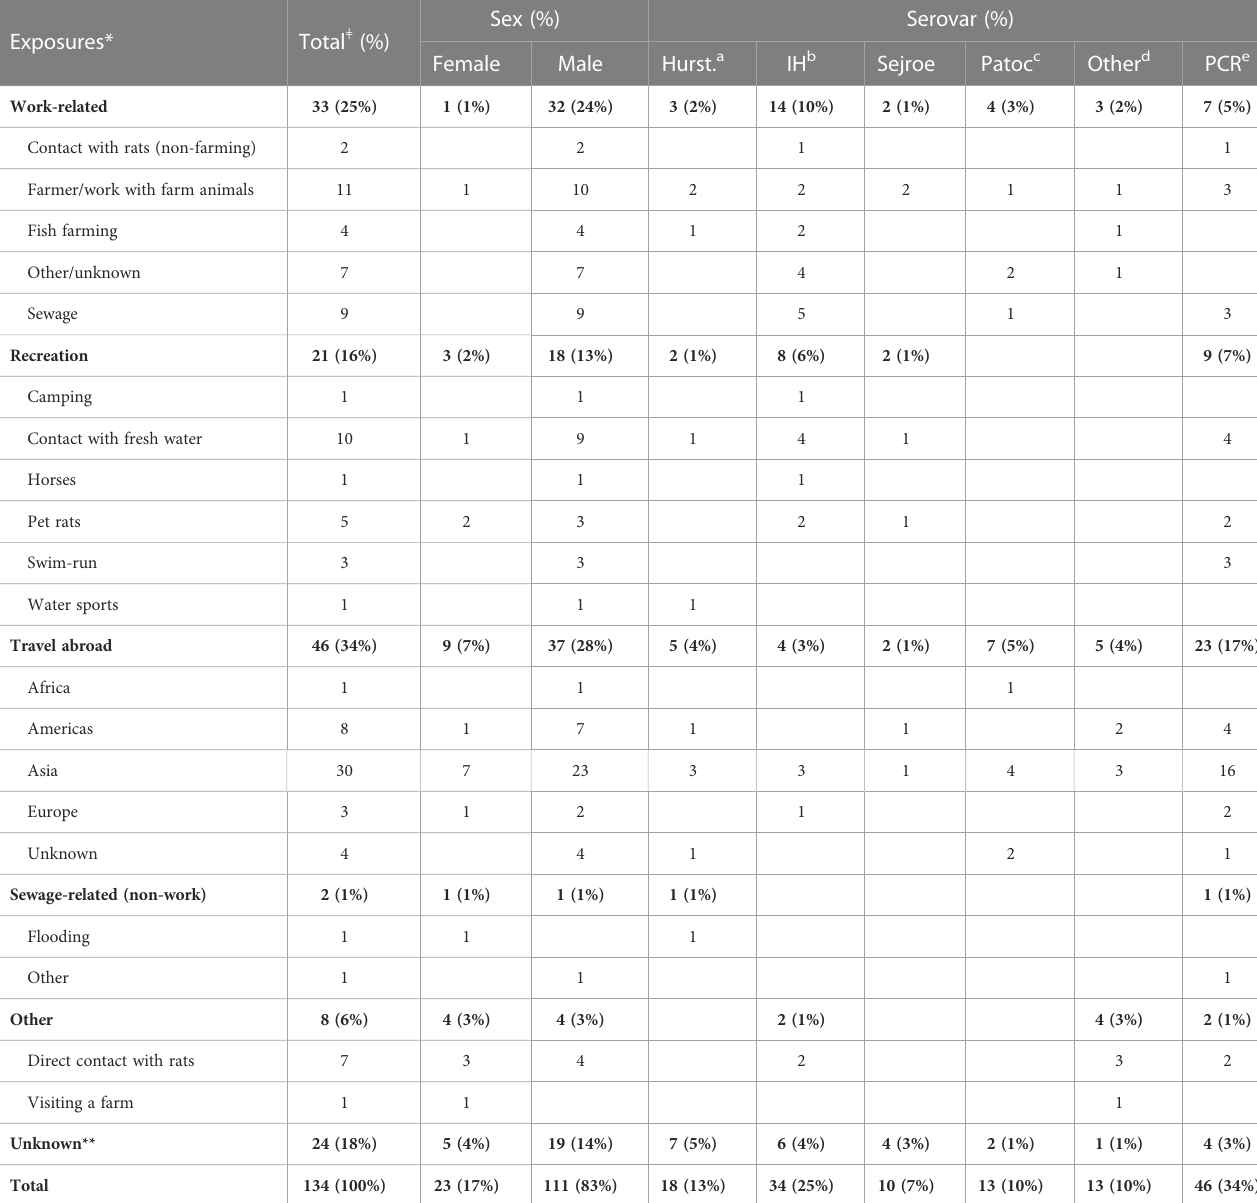
TABLE 2 Main sources and subgroups of reported exposure of leptosporosis by sex and serovar in Denmark, 2012-2021 (N=134).